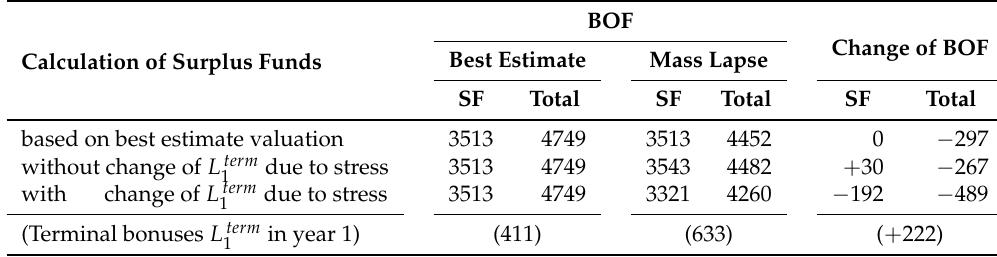
Table 13. Change of relevant BOF components in the mass lapse scenario (in A